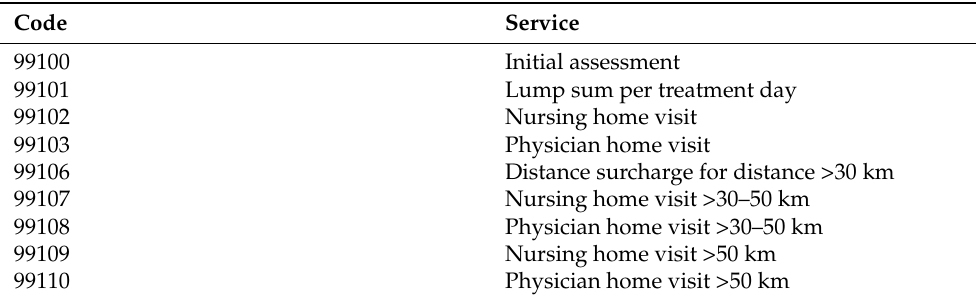
Table 1. Palliative-specific, specialised ambulatory services according to the Association of Statutory Health Insurance Physicians in Mecklenburg-Western